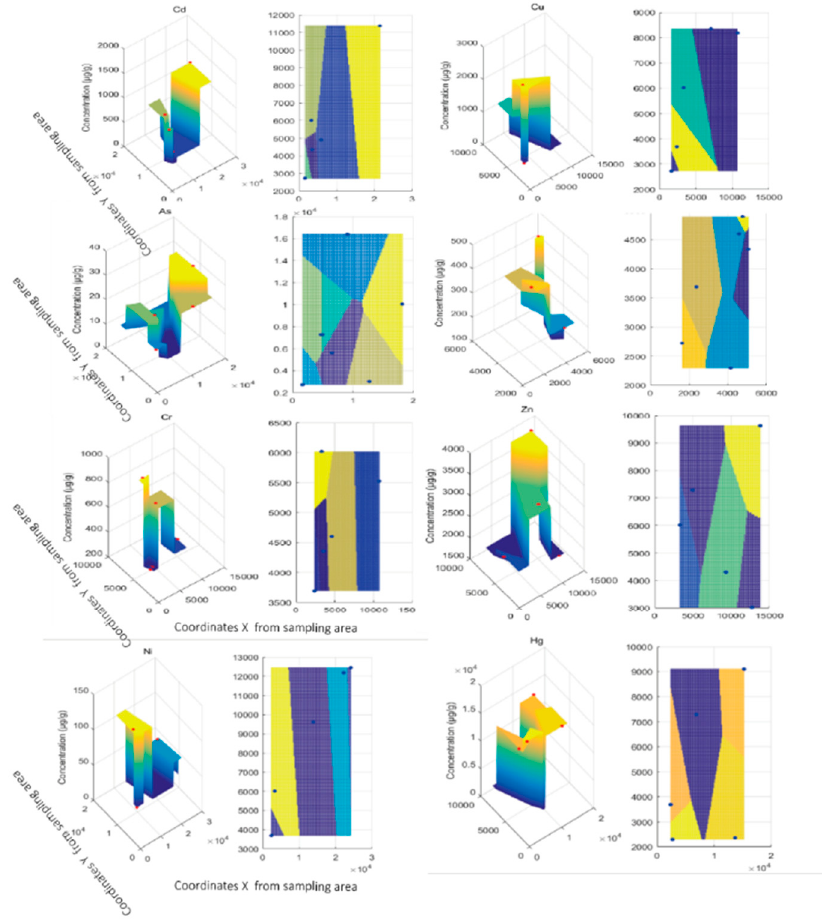
Figure 9. Stereo and plane views of the heavy metal pollution sources.